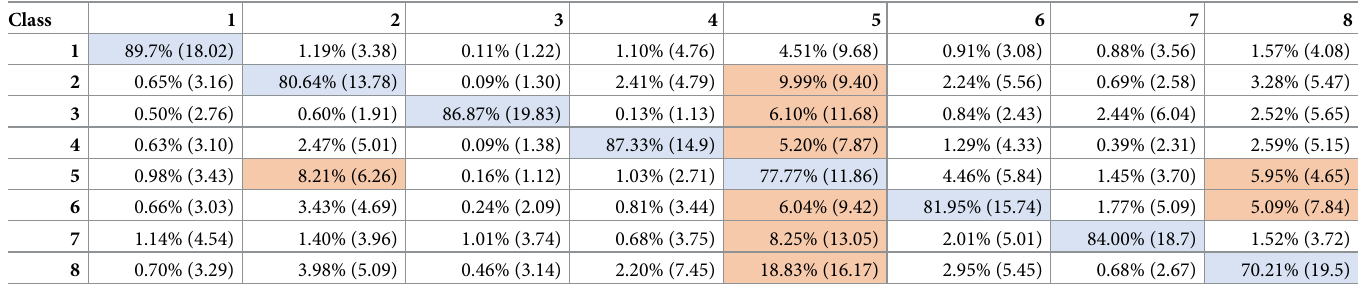
Table 4. Mean Probability of Class Membership (Mean (SD)) � .